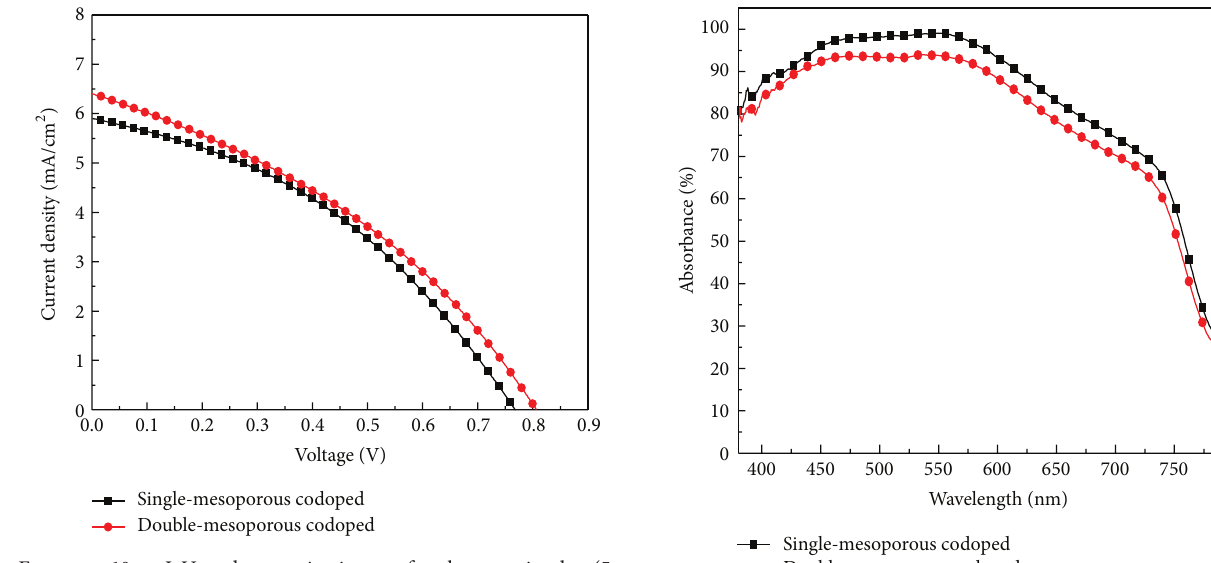
10: J - V characterization of the optimal (5- AVA ) 𝑥 ( MA ) (1−𝑥) PbI (3−𝑦) Cl 𝑦 -based PSCs with single- and double- mesoporous layer.